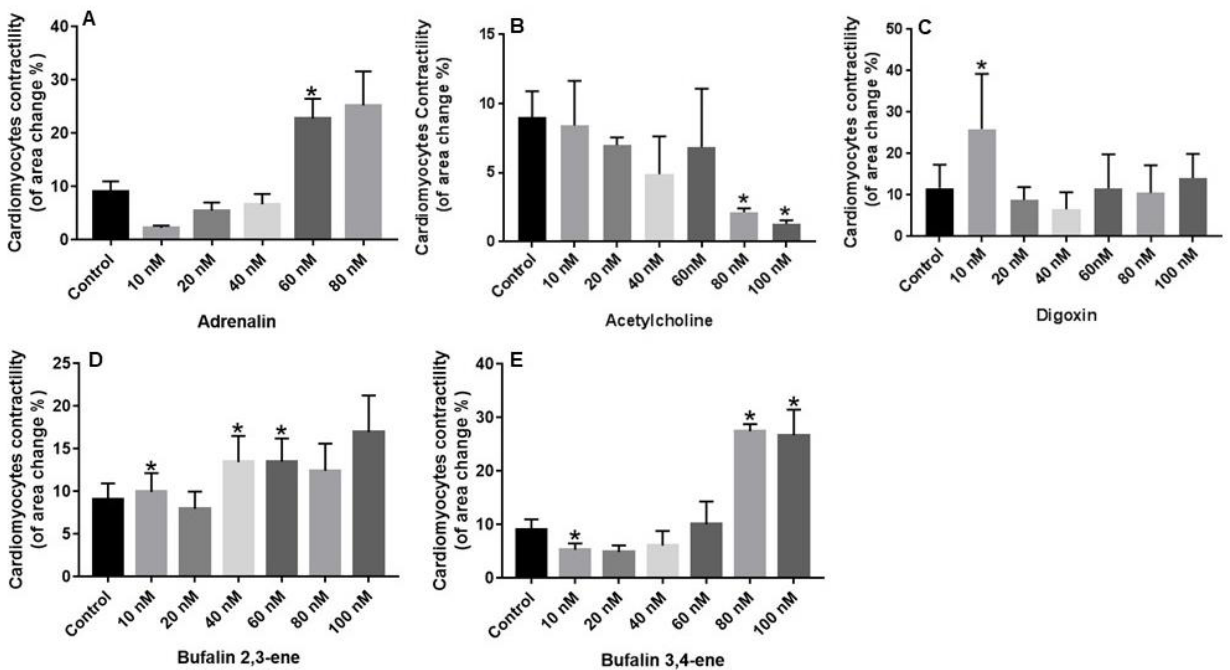
Figure 9. Effect of bufalin-2,3-ene and bufain-3,4-ene on quail cardiac cell contractility. Quail cardiomyocyte preparation and contractility measurements were performed as described in Materials and Methods. Contractility at 37°C was measured 30 min after drug addition. Cells were photographed for 15 s, and the change in cell contraction was deduced from the mean difference in area change between relaxation and the contraction peaks. Three cell clusters in 3 wells were photographed and measured for each experimental condition. Quantification of motility is presented as cell area change. The effect of adrenalin ( A ), acetylcholine ( B ), digoxin ( C ), bufalin 2,3-ene ( D ), and bufalin 3,4-ene ( E ) at different concentrations is shown. Bar graphs represent the mean ± SE. of 3 experiments. Values significantly different from that of the control =, * p <0.05.